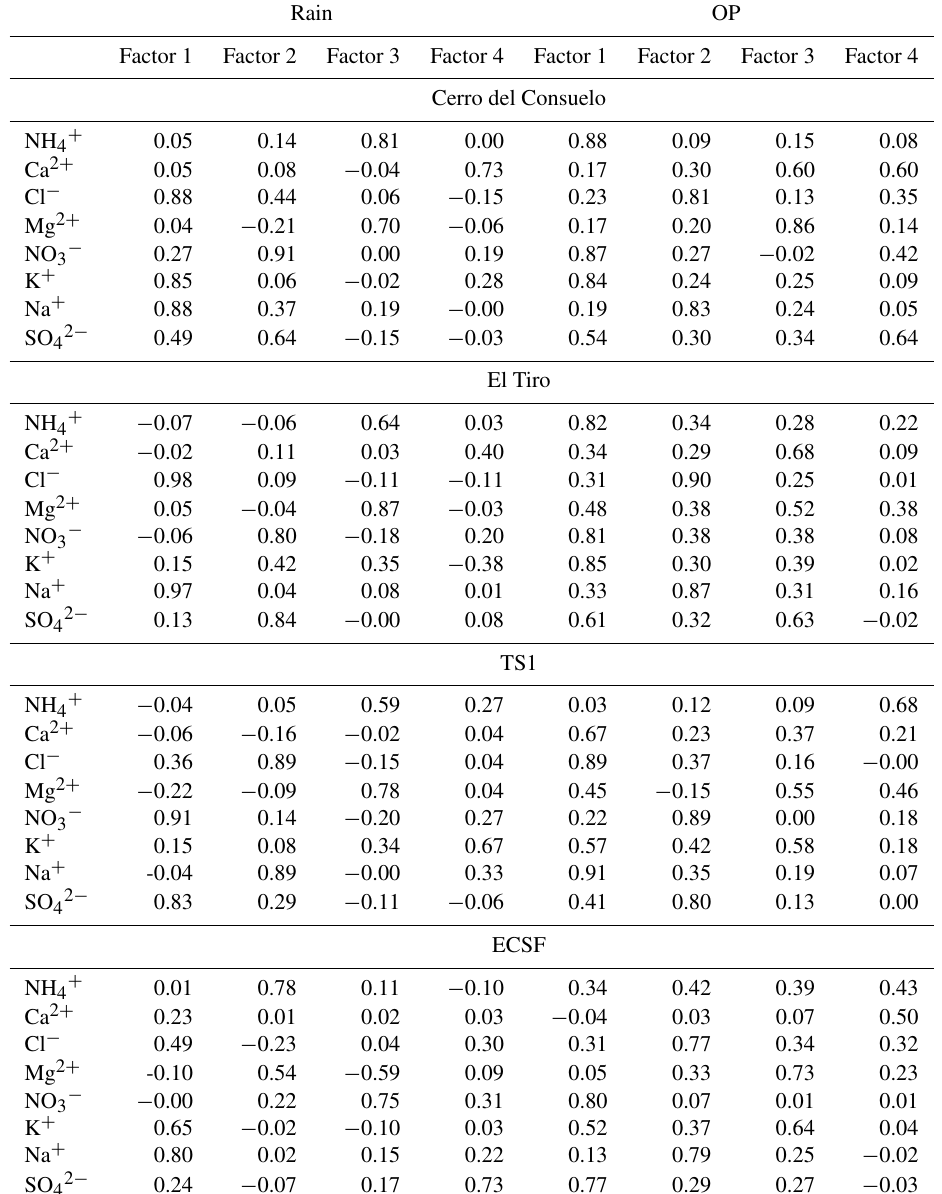
Table 2. Loadings from PFA with varimax rotation of major ions in rain and OP samples from Cerro del Consuelo, El Tiro, TS1, and ECSF meteorological